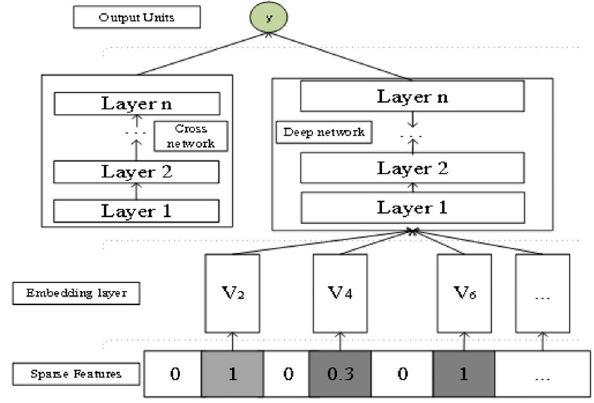
Fig. 5 Network topology of DCN